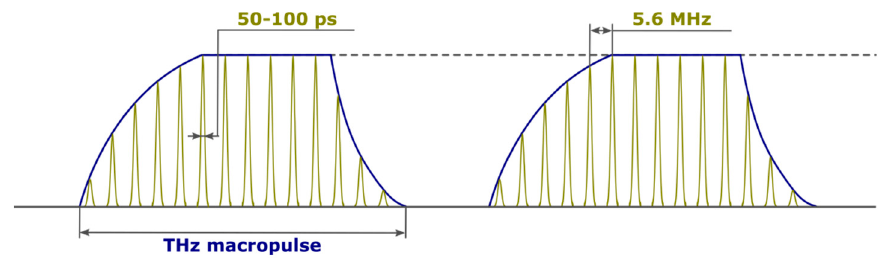
Figure 2. Schematic view of NovoFEL radiation macropulses. The length of the individual THz pulse and pulse repetition rate are shown for 1st FEL.